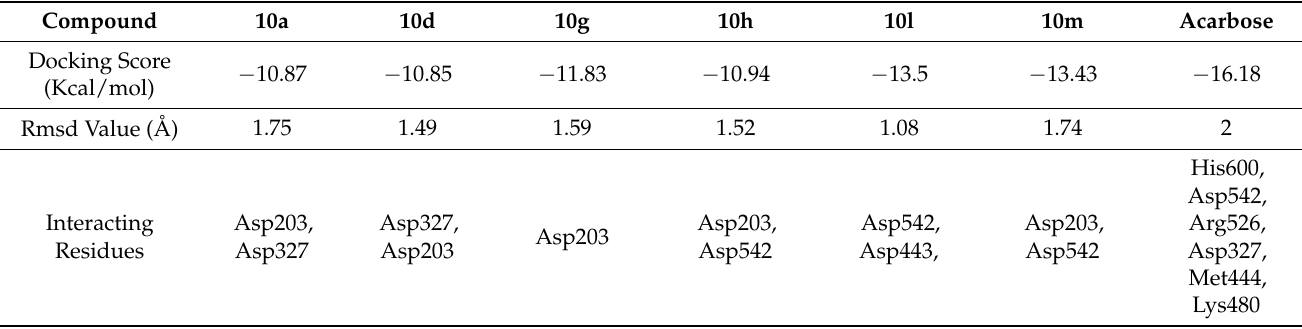
Table 1. In silico screening results of benzimidazolium salts 9a – m and 10a – m